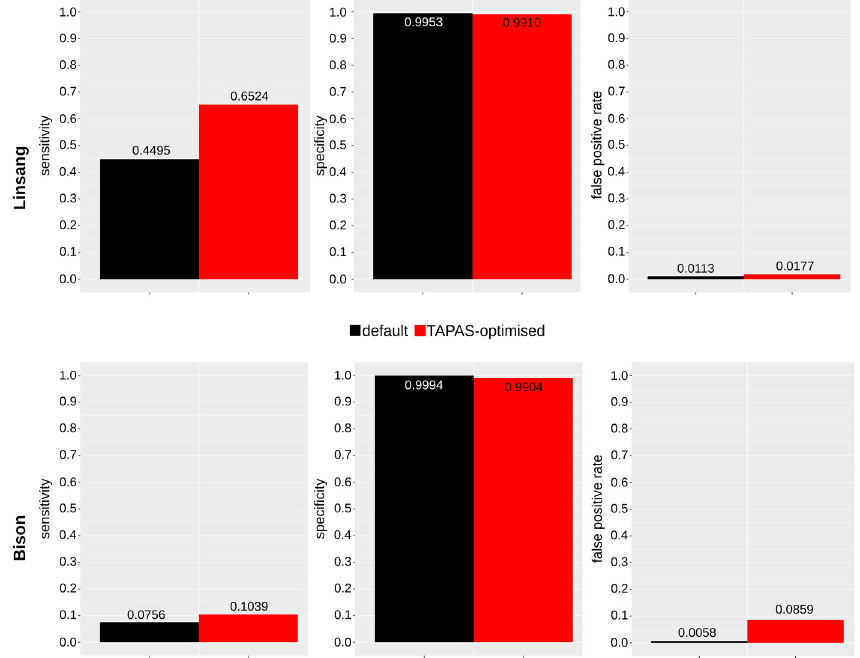
Figure 4. Sensitivity, specificity, and false positive rates of mapping using BWA aln with default parameters (black) and with the optimized parameters (red) based on the simulated data for the linsang (top) and bison (bottom). Using TAPAS, we can show an improvement of sensitivity (1.5-fold for the linsang and 1.4-fold for the bison) with only limited reduction in specificity while keeping the false positive rate low. This figure was generated using R (v3.4.2 and v3.4.3 [37]).